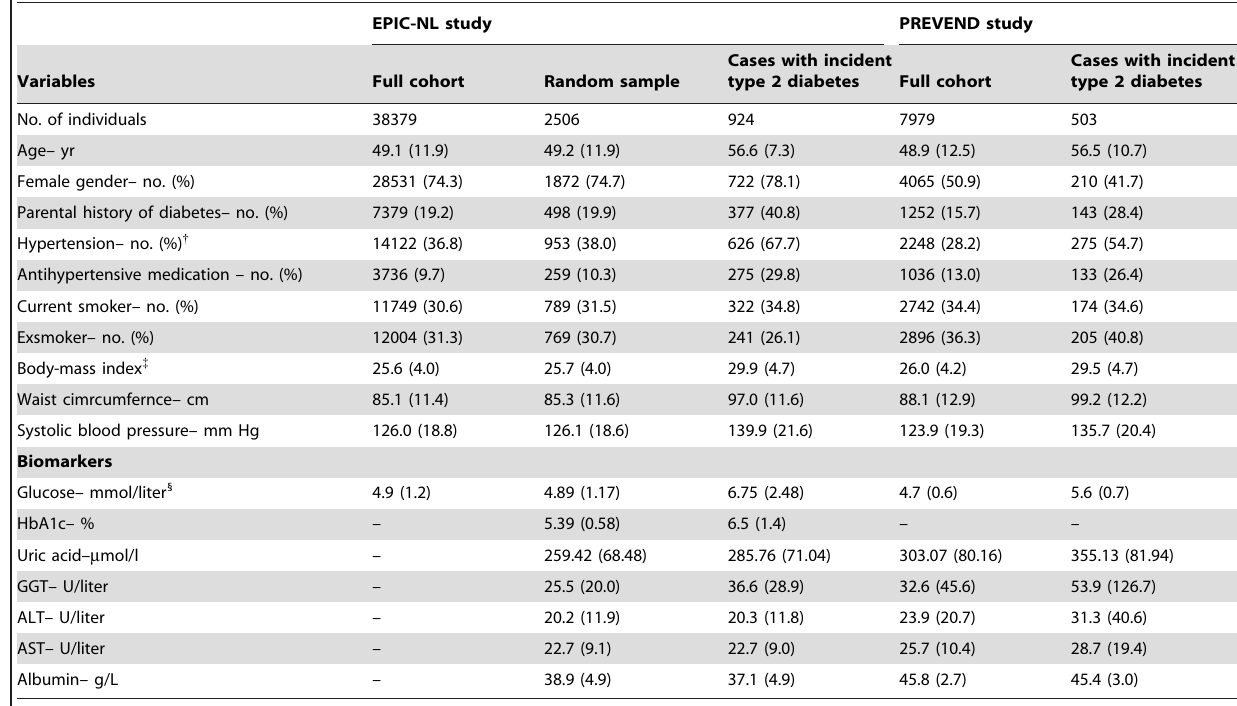
Table 1. Baseline participants’ characteristics in each